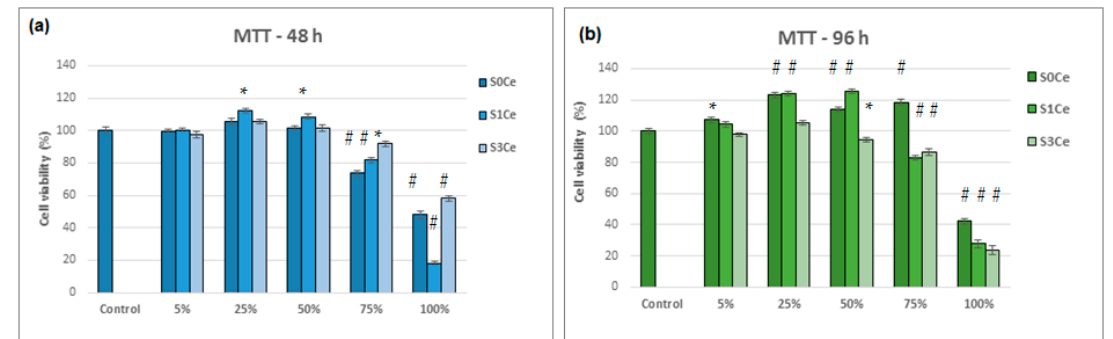
Figure 10. Viability of L929 cells exposed to different concentrations of PMMA-MBGs composite scaffolds evaluated by MTT assay after 48 h ( a ) and 96 h ( b ). Data are presented as mean ± SD ( n = 3). * p < 0.05 compared to control (untreated cells); # p < 0.01 compared to control (untreated cells).